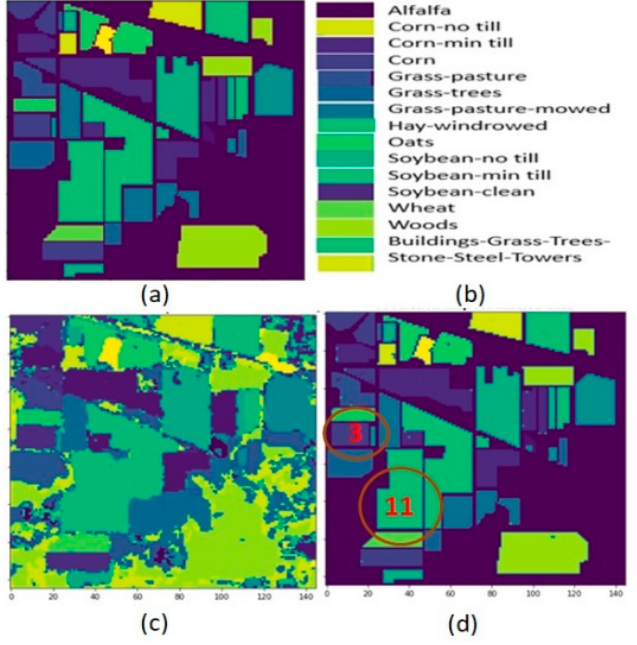
Figure 8. Indian Pines data ( a ) Ground truth ( b ) Category label ( c ) Crop classification result on entire data ( d ) Crop classification result.